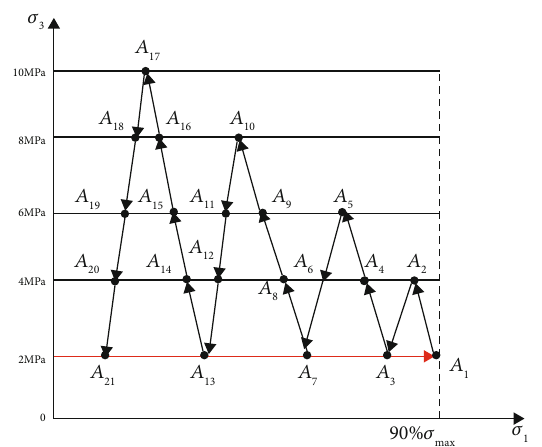
Figure 8: Penetration tests with di ff erent con fi ning pressure loading and unloading